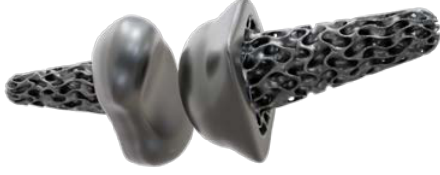
Figure 2. CAD model of the finger joint implant.